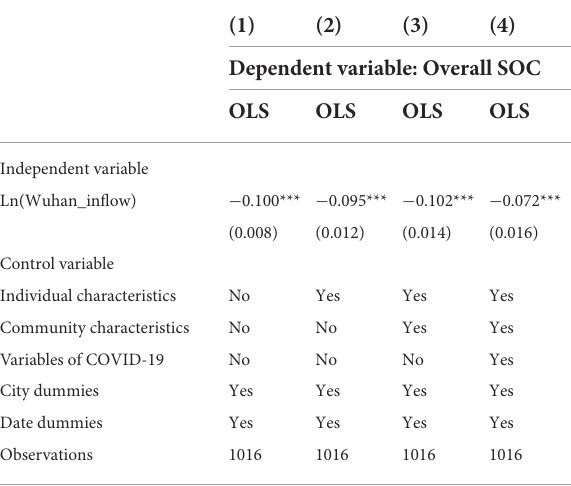
TABLE 5 The impact of population inflow from Wuhan city on the sense of confidence of residents in controlling COVID-19 outbreak at the destination cities.